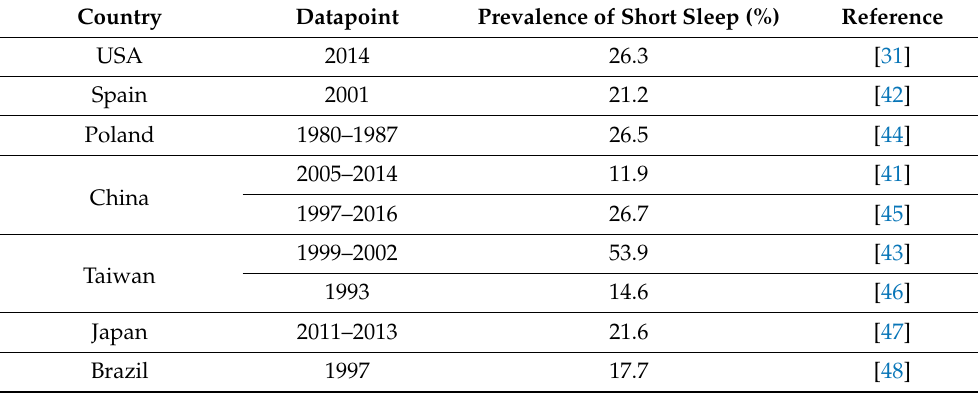
Table 3. Pre-pandemic prevalence of short sleep duration in the ageing segment of the